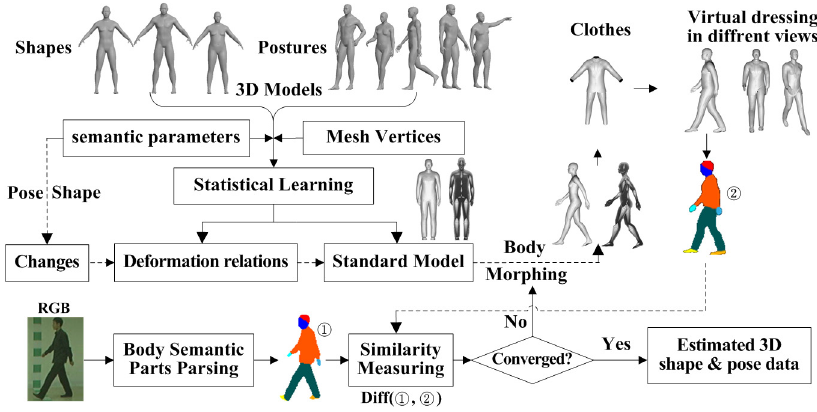
Figure 2. Estimation of 3D body pose and shape data.